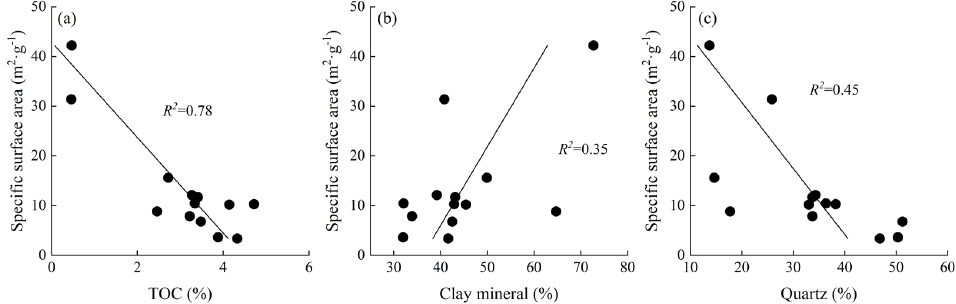
Figure 8. ( a ) Relationship between specific surface area and TOC; ( b ) Relationship between specific surface area and clay mineral; ( c ) Relationship between specific surface area and quartz.